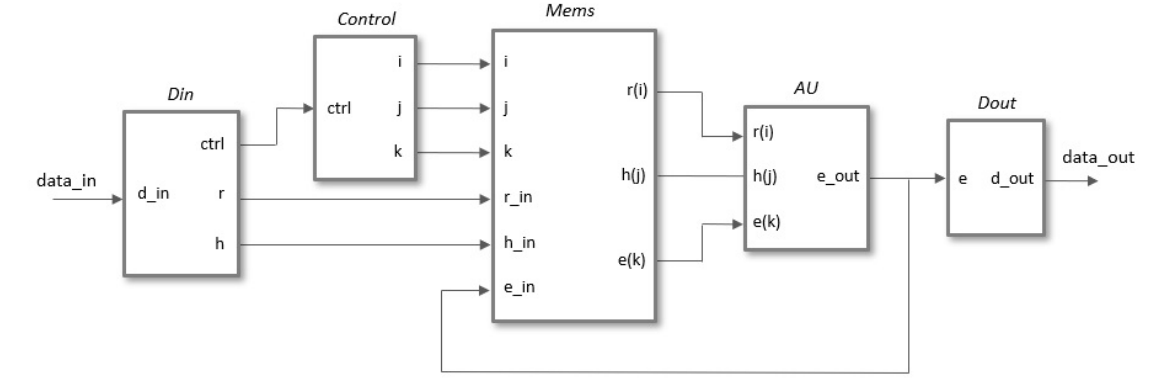
Figure 12. Inclusion of input and output interfaces for connecting the multiplier IP module through AXI4-Stream